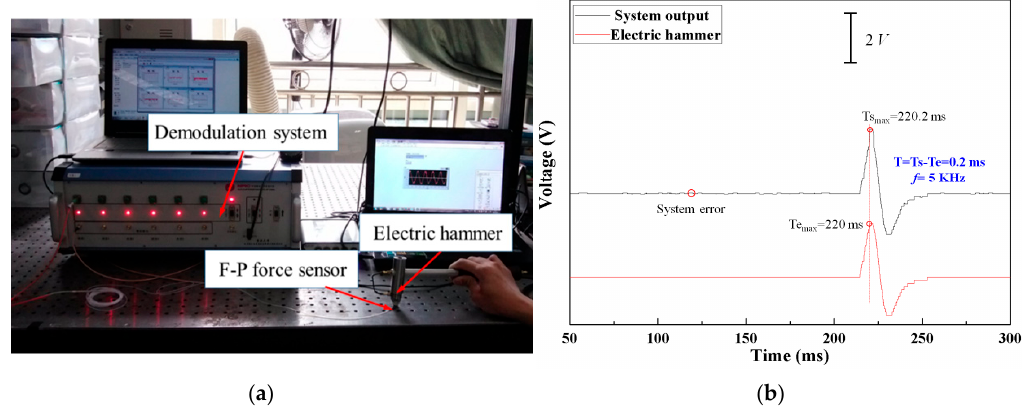
Figure 14. ( a ) The experimental equipment; ( b ) output of electric hammer and the whole demodulation system.